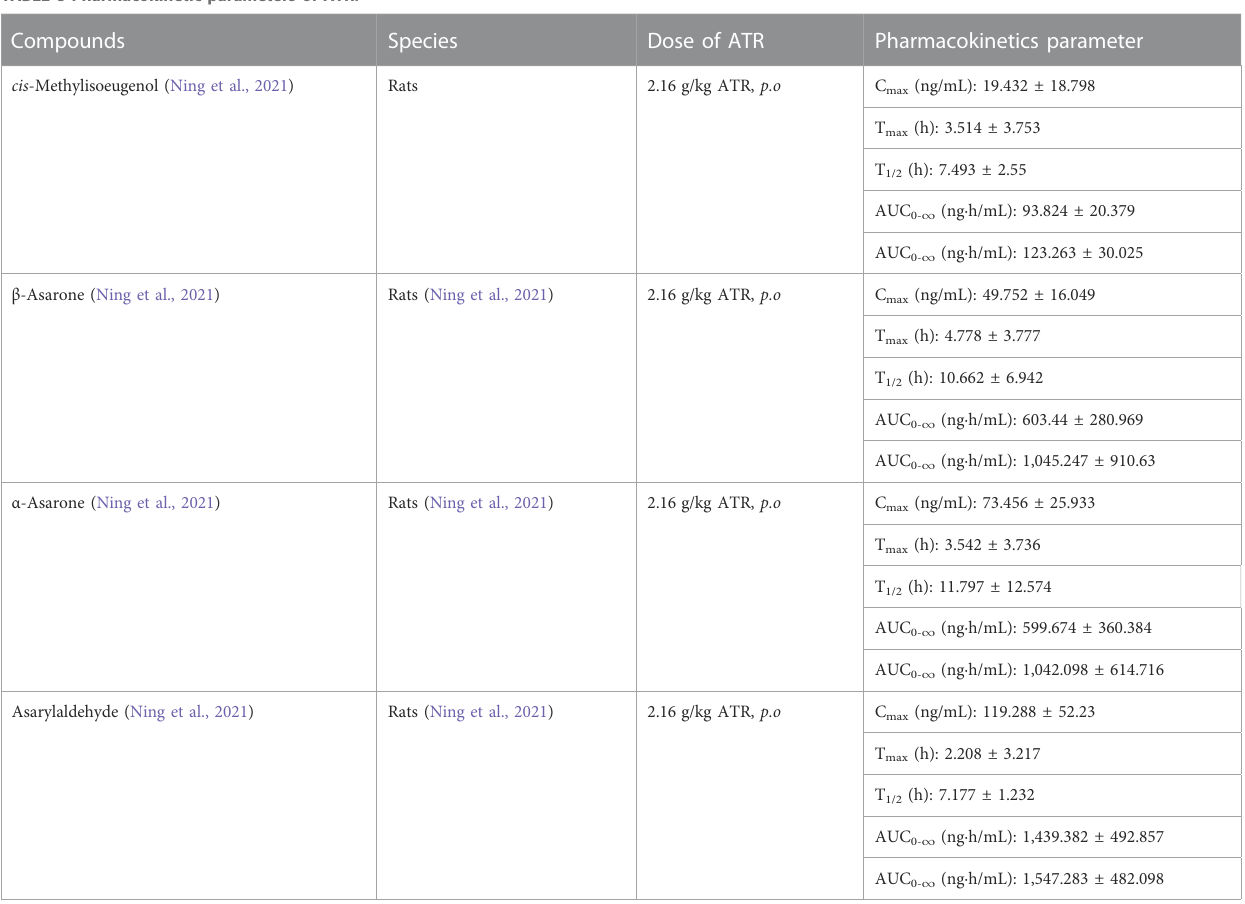
TABLE 8 Pharmacokinetic parameters of ATR.